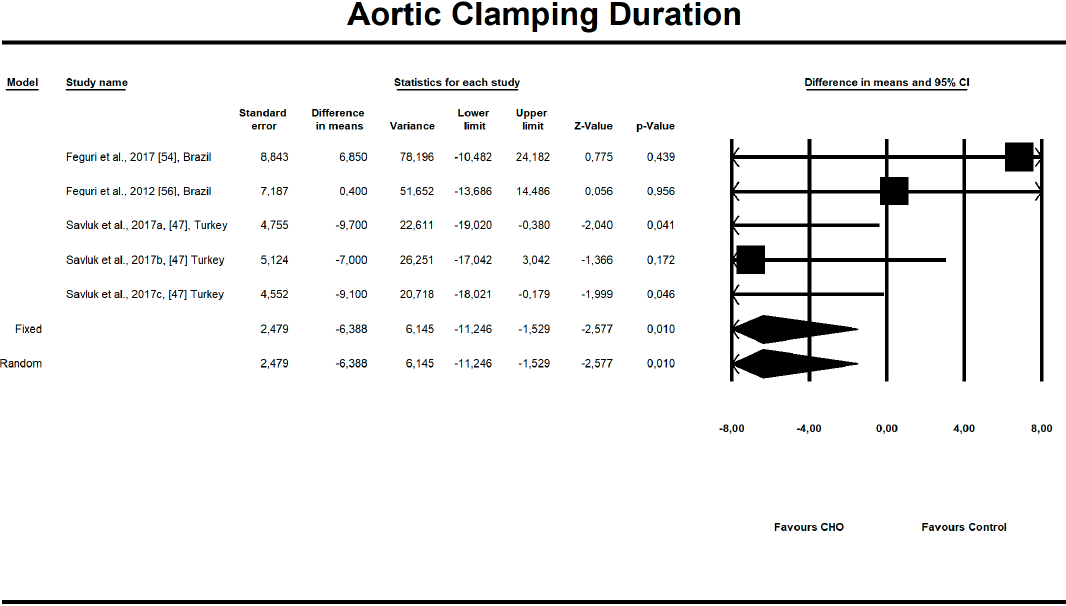
Figure 4. An effect size standardized mean difference, for intensive unit care (ICU) stay (hours) in patients taking oral carbohydrates (OCH) drinks vs. controls. Std diff in means ‐ standardized mean difference; 95%Cl – 95% confidence interval.